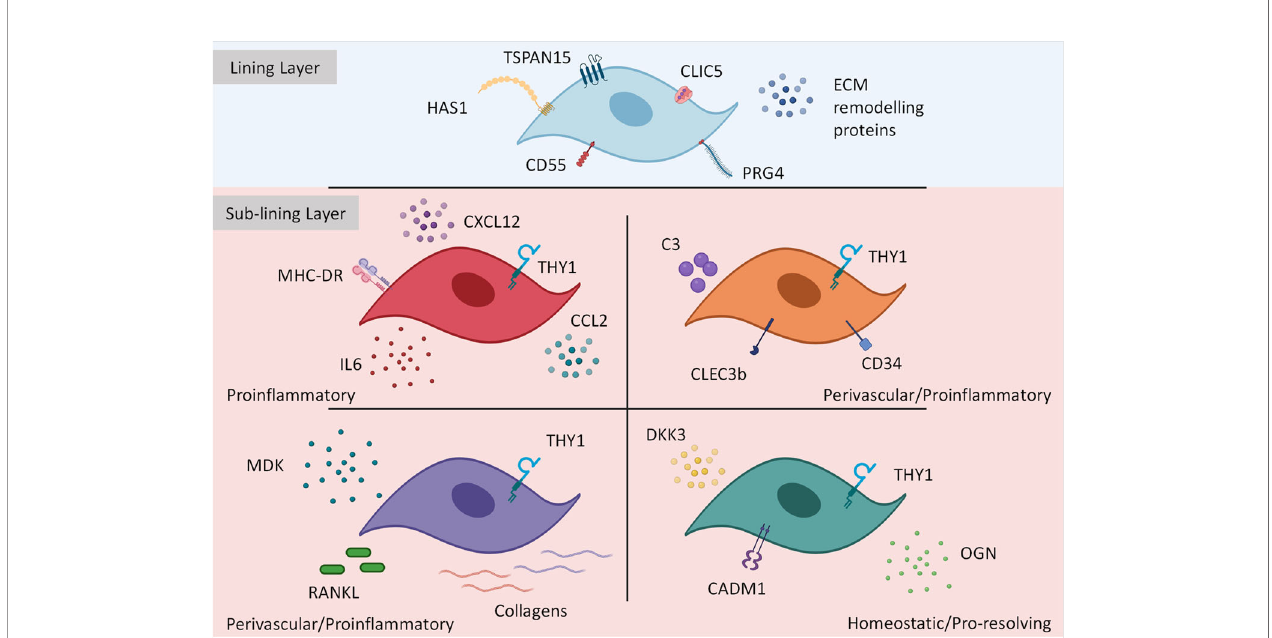
FIGURE 2 | Transcriptionally and functionally distinct synovial fi broblast subsets within the in fl amed joint. Synovial fi broblasts exist as distinct subsets or activation states. Lining layer fi broblasts play an important role in tissue repair and remodelling however, in response to in fl ammation these fi broblasts may play a role in bone and cartilage destruction. In contrast, sub-lining fi broblasts discriminated by THY1 expression (with a transcriptional gradient extending from the vascular loci (highest THY1 expression) to the synovial lining) expand during in fl ammation Within the sub-lining tissue, four differentially activated fi broblast subsets have been identi fi ed expressing distinct transcriptional cassettes determined by anatomical location within the joint. This fi gure is based on human and mouse data. Image created with